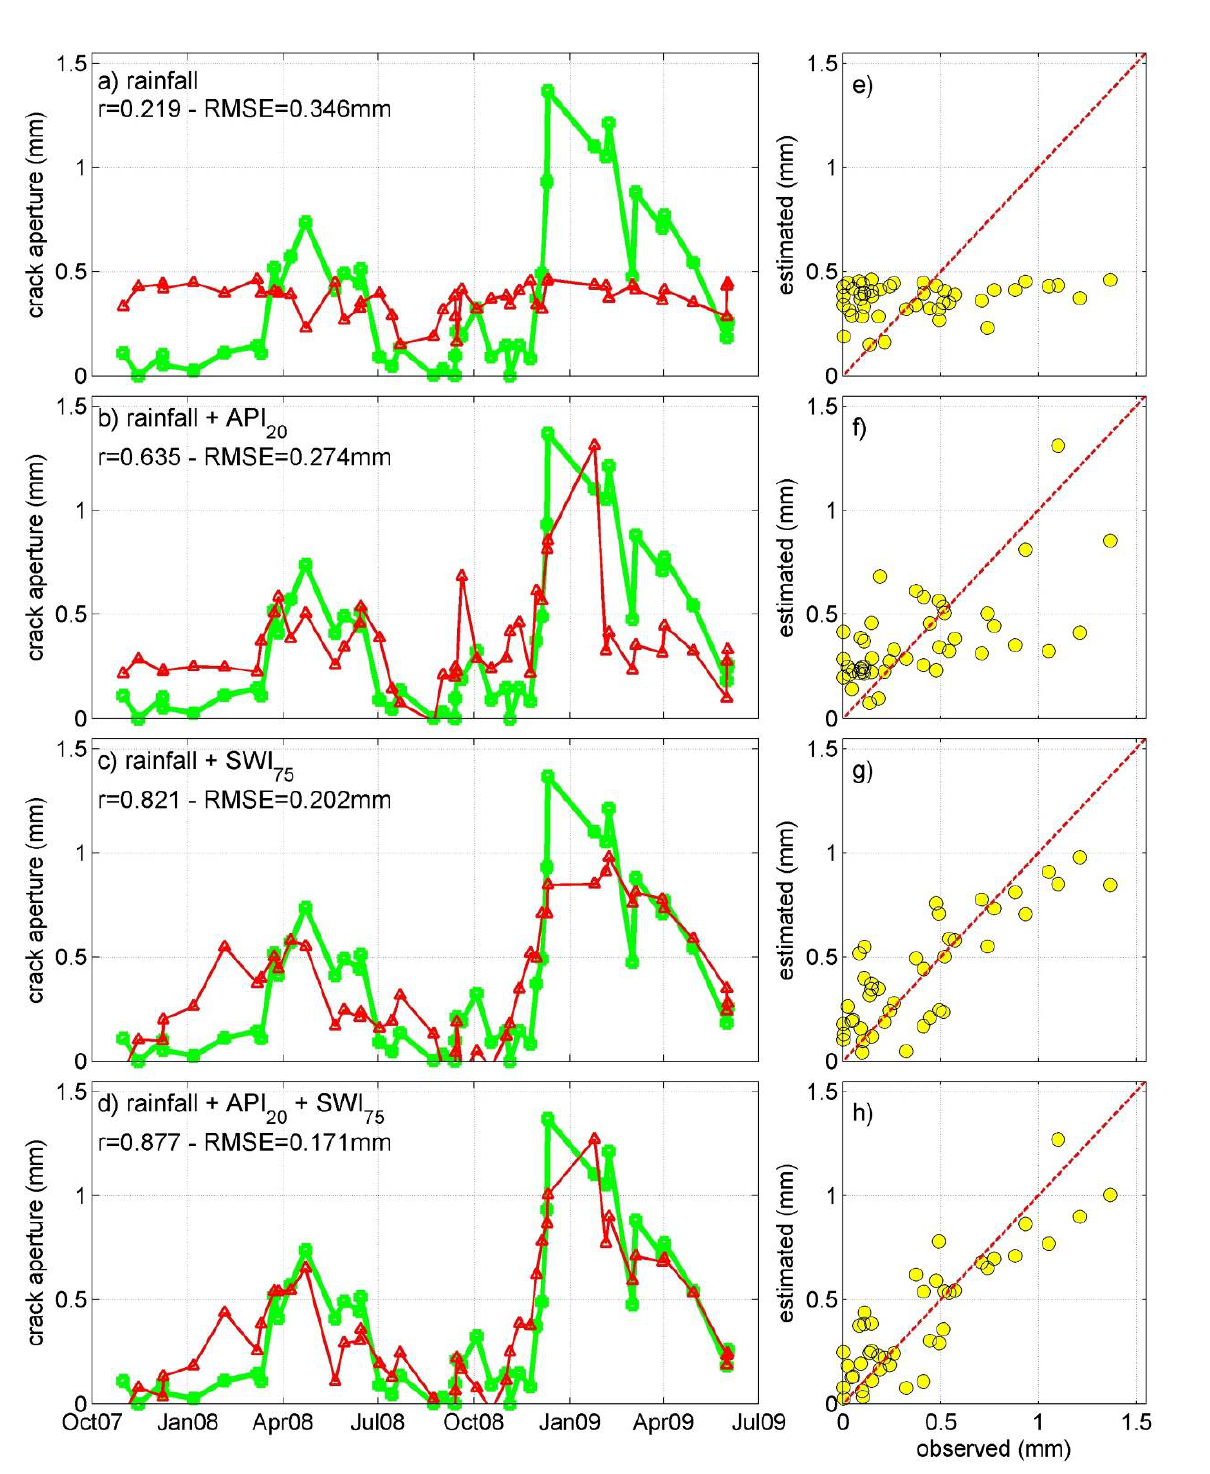
Figure 3. Comparison between observed (circles) and estimated (triangles) crack aperture from the beginning to the end of the selected rainfall events: ( a–d ) time series, and ( e–h ) scatter plots (r: correlation coefficient, RMSE: root mean square error). The predictors are: (a,e) rainfall variables ( i.e. , total rainfall and maximum rainfall for duration of 1 h; (b,f) rainfall and Antecedent Precipitation Index, API , with N =20 days; (c,g) rainfall and N ASCAT Soil Water Index, SWI , with T = 75 days; (d,h) rainfall, API and SWI T 20 75